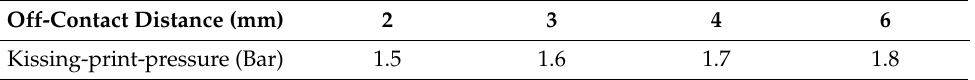
Table 2. Dependence between the off-contact distance and the kissing-print pressure. Off-Contact Distance